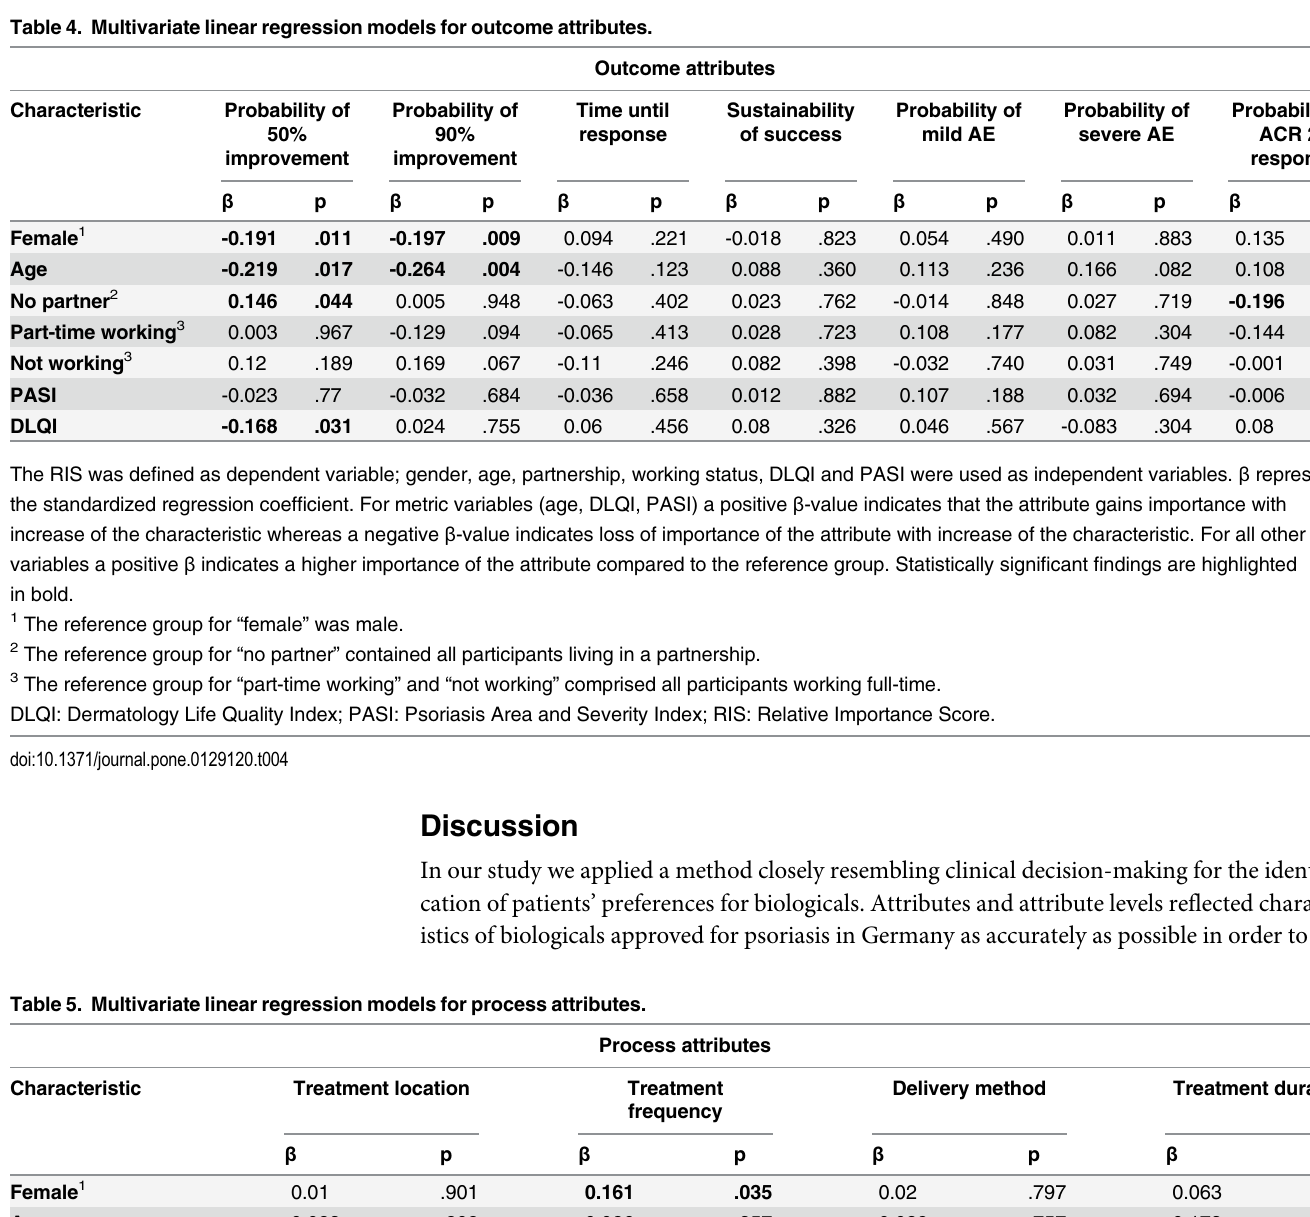
Outcome attributes